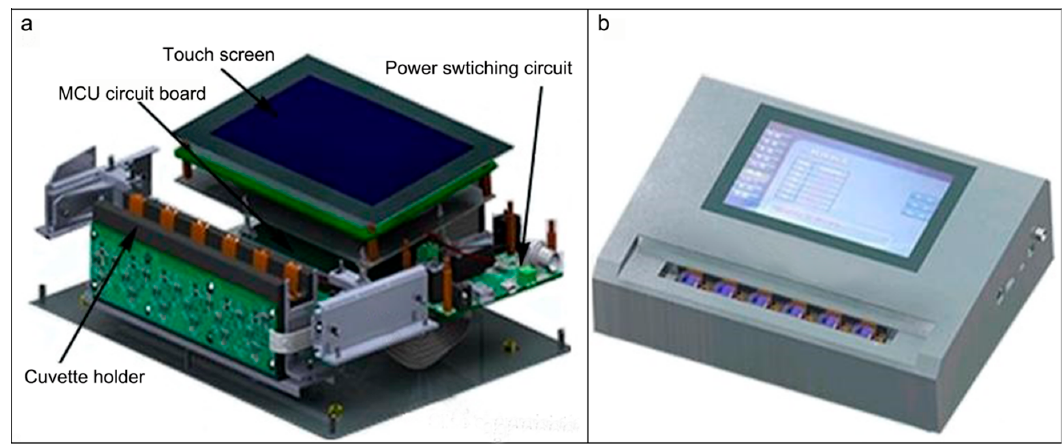
Figure 3. Multichannel optoelectronic measurement system: ( a ) components of the multichannel optoelectronic system, ( b ) prototype of the multichannel optoelectronic measurement system.